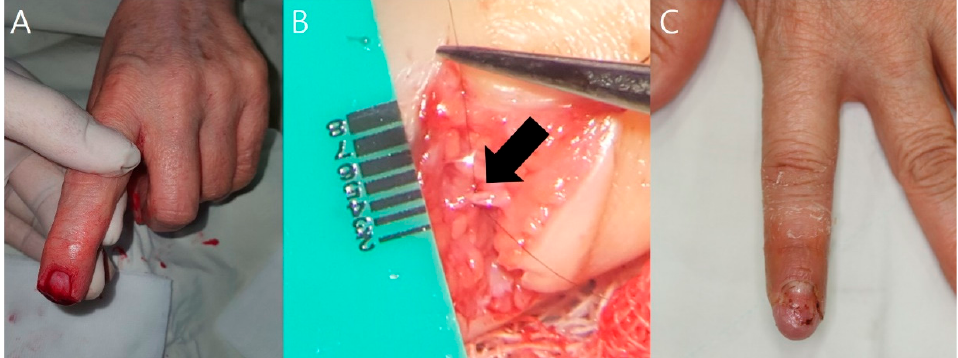
Figure 2. Case 1 (patient 20). ( A ) A 60-year-old patient with an amputated left index finger. ( B ) Black arrow indicates the vessel that was anastomosed using the 2-point suture technique. ( C ) Three months postoperatively, the patient did not complain of any functional